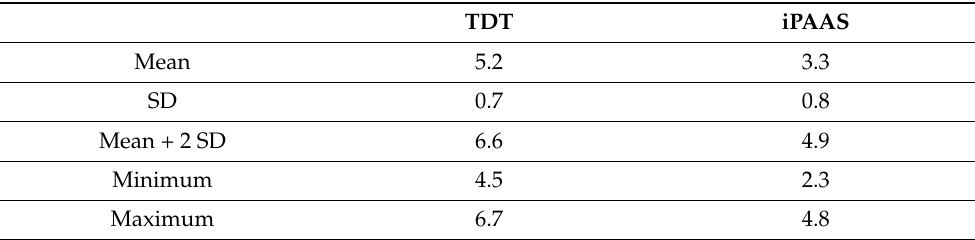
Table 3. Descriptive results for the GD thresholds (given in ms) for the laboratory-based system (TDT) and iPAAS system.